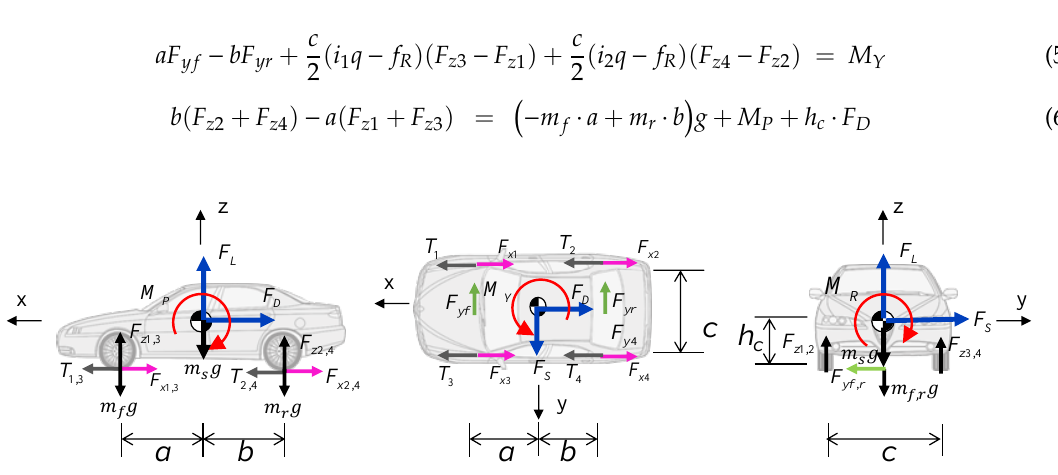
Figure 1. Applied actions and corresponding tire forces of two-axle vehicles.